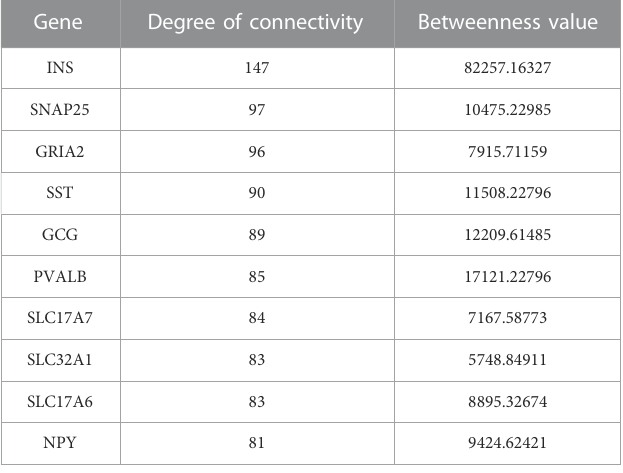
TABLE 4 Top 10 hub genes with higher degree of connectivity and betweenness value.